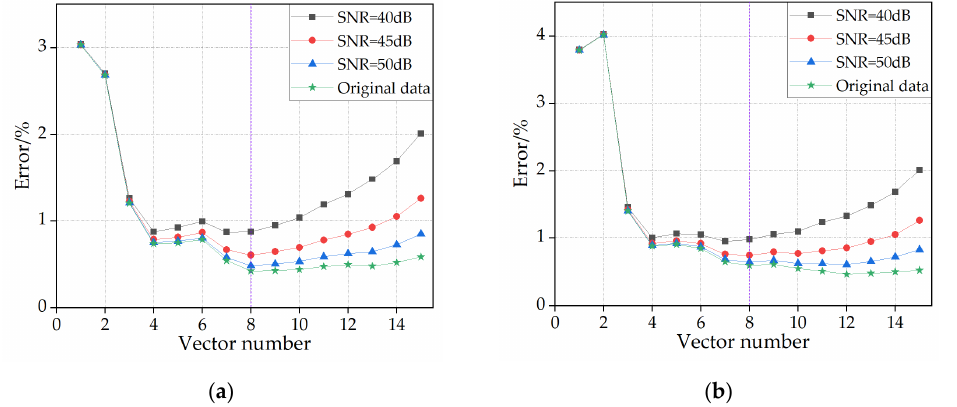
Figure 3. Comparison of reconstruction errors between different POD basis vectors with different noise levels (original measurement data, signal-to-noise ratio (SNR) = 40 dB, SNR = 45 dB, SNR = 50 dB). ( a ) Comparison in test case 2. ( b ) Comparison in test case 4.